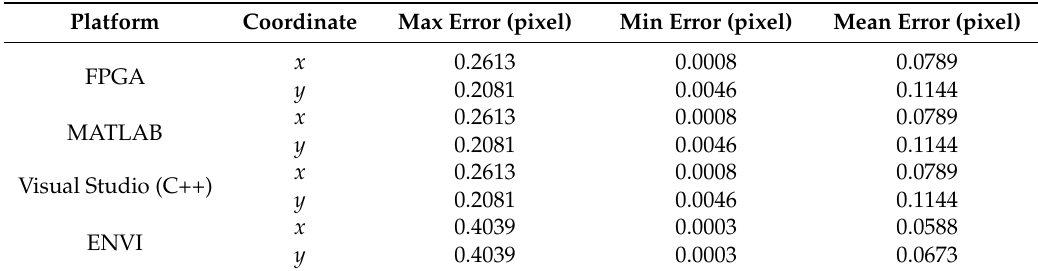
Table 6. Statistics values of the georeferenced image of the second image.